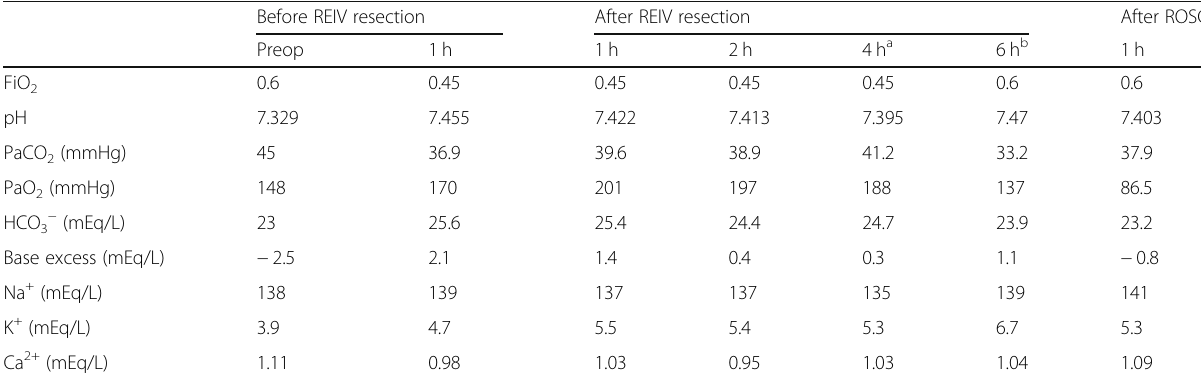
Table 1 Perioperative change in arterial blood gases and compounds Before REIV resection After REIV resection After ROSC Preop 1 h 1